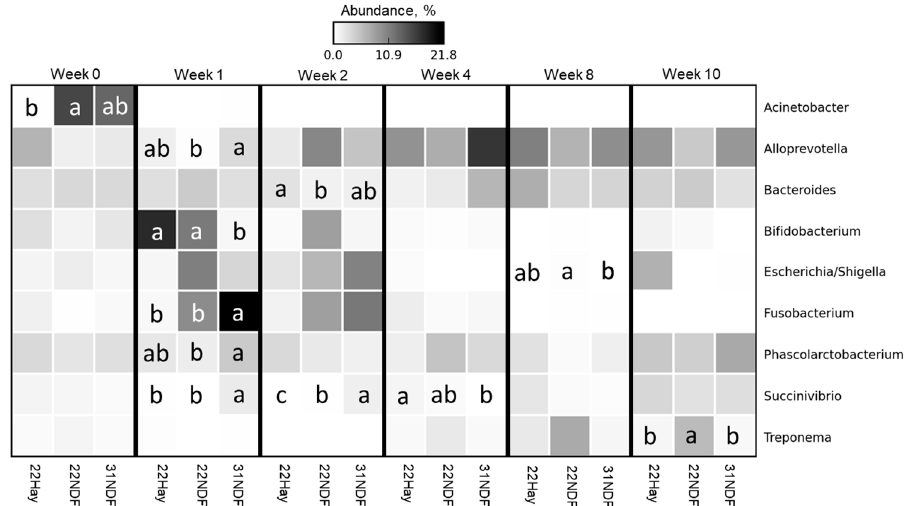
Figure 7. Differential abundance in most abundant bacterial genera in fecal samples of dairy calves fed different levels and sources of NDF. Data are visualized as heatmap. Comparisons are among treatments within week. Means followed by the same letter are not significantly different by the t -test ( p > 0.05). Genera rows without letters were not significantly different; 22NDF—calves fed starter concentrate with 220 g NDF/kg; 22Hay—calves fed starter concentrate with 220 g NDF/kg and grass hay; 31NDF—calves fed starter concentrate containing 310 g NDF/kg.